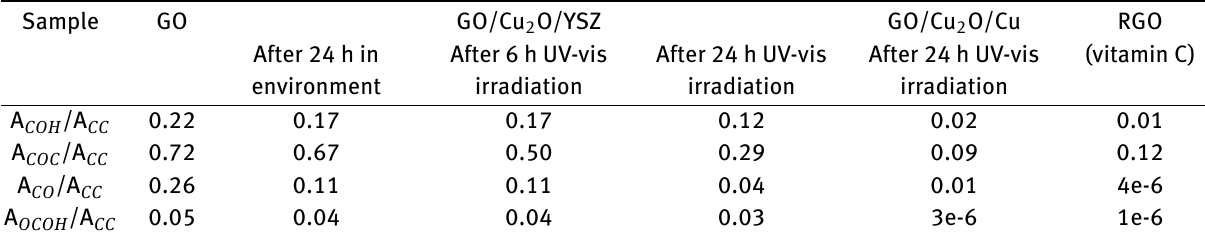
Table 1: The peak area (A) ratio of oxygen-containing bonds to the non-oxygenated ring CC bonds for GO sheets deposited on YSZ substrate, MOD-Cu 2 O and self-oxidation Cu 2 O films after light irradiation, as compared to those of the vitamin C-reduced GO Sample GO GO/Cu 2 O/YSZ GO/Cu 2 O/Cu RGO After 24 h in After 6 h UV-vis After 24 h UV-vis After 24 h UV-vis (vitamin C) environment irradiation irradiation irradiation A COH /A CC 0.22